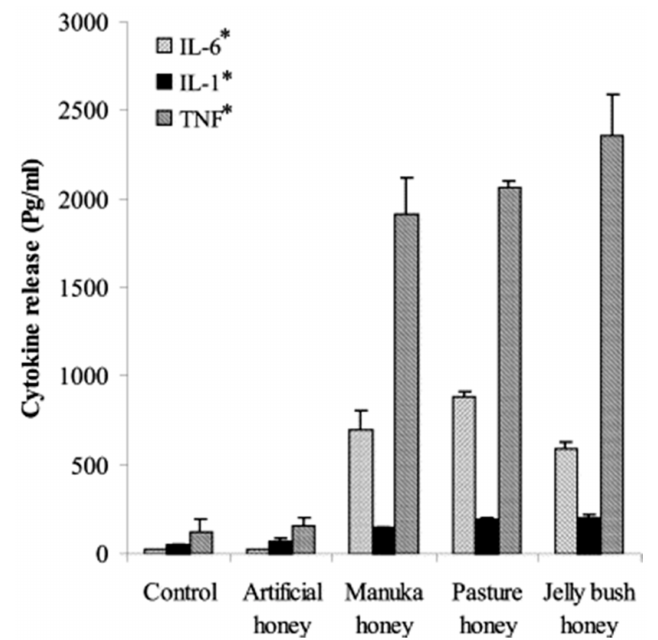
Figure 1. Honeys induce monocyte inflammation response. IL-6, IL-1, and TNF release from peripheral blood monocytes over 18 h in the presence of artificial honey (syrup control), Manuka honey, Pasture honey, and Jelly Bush honey. “*” indicates statistical significance ( p < 0.001, analyzed by ANOVA with a Tukey pair-wise comparison). Reproduced with permission from Tonks et al., Cytokine ; published by Elsevier,